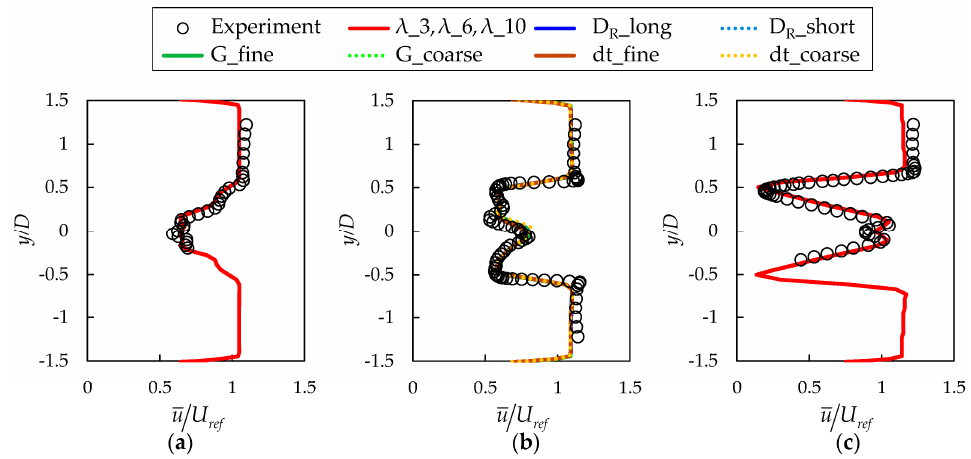
Figure 4. Lateral distribution of the streamwise wind velocity at the hub height in the wind-turbine wake at x / D = 1. ( a ) λ = 3; ( b ) λ = 6; and ( c ) λ = 10.